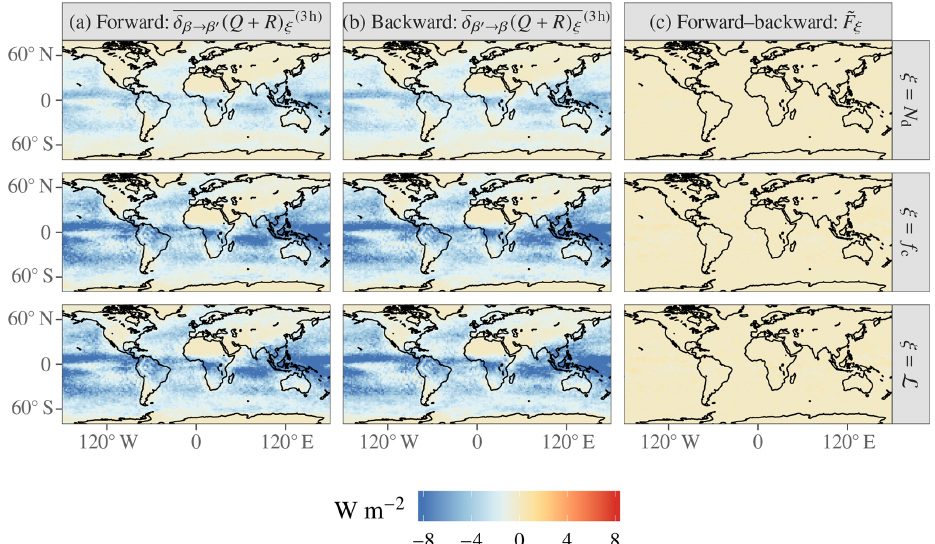
Figure A2. Forward (a) , backward (b) , and forward–backward (c) PRP performed on the same-climate–different-weather case. Note the significantly wider color scale than in Fig.